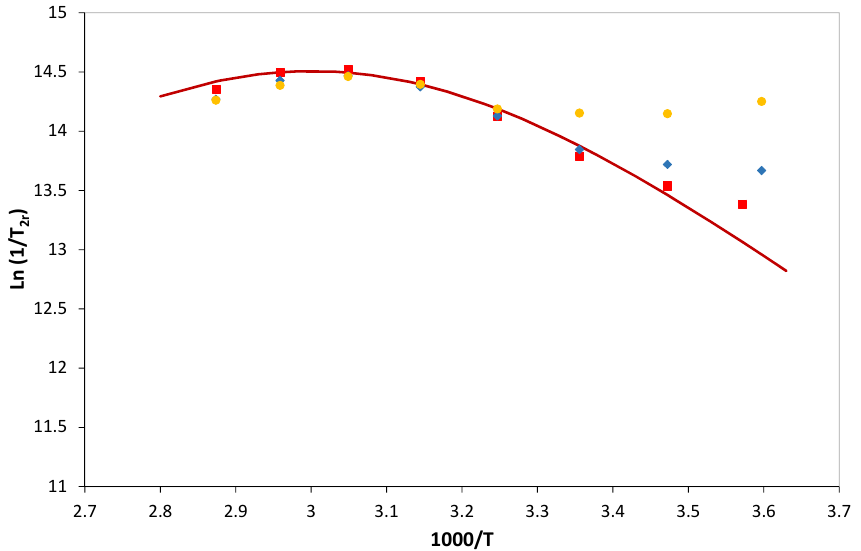
Figure 4. Temperature dependence of the reduced 17 O transverse relaxation rates of 1 ( (cid:7) , 10.04 mM) 2 ( • , 3.2 mM), and 3 ( (cid:4) , 10.33 mM) at 9.4 T and pH = 7.0. The continuous curve represents the best fit to the experimental data points of 3 . Table 1. Water exchange rates ( k ex298 ) of various GdDOTA derivative complexes.